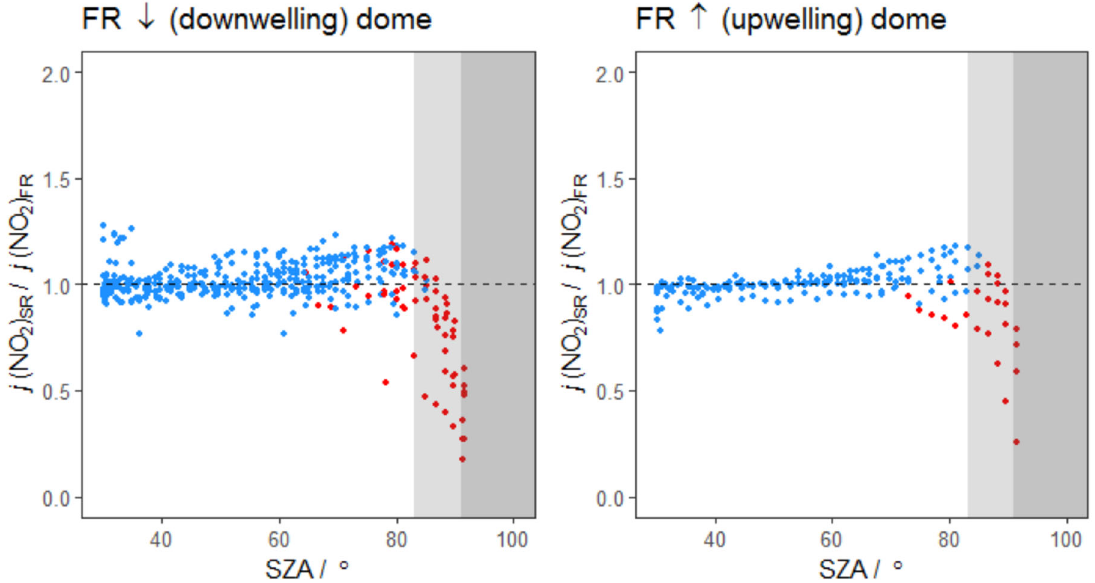
Figure 2. Ratios of spectroradiometer to filter radiometer photolysis frequencies measured during the co-location calibration period as a function of SZA. Black dashed lines show the 1:1 ratio. Red points indicate values less than 5% of the maximum value for j (NO 2 ) observed during the calibration. The light shading indicates SZA during the ‘golden hour’, defined here as 5 ◦ above the horizon, while the dark shading shows sunrise/sunset SZA of ≥ 90 ◦